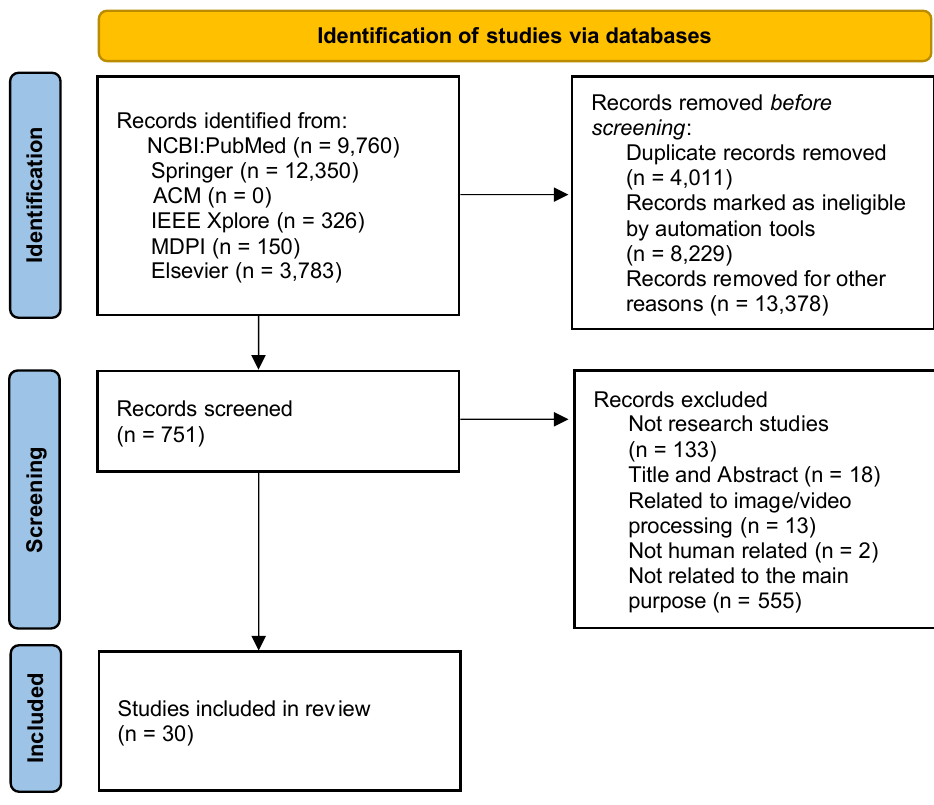
Figure 1. A flow diagram of the paper selection.